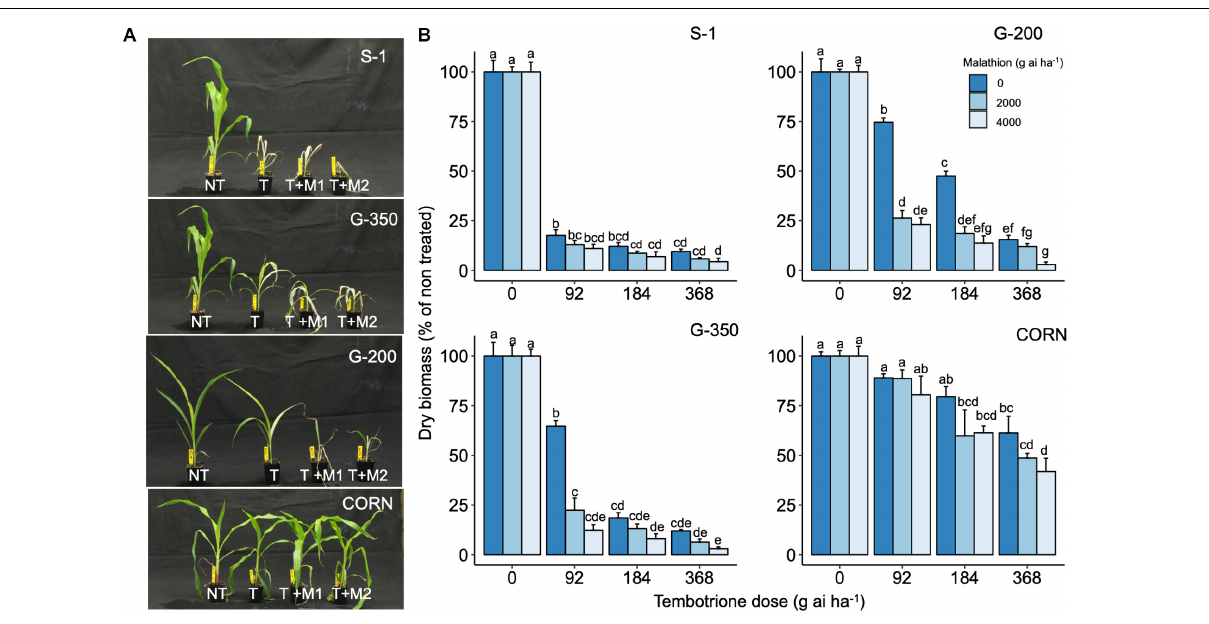
FIGURE 3 | (A) The response of S-1 (susceptible), G-200, G-350 (resistant), and corn to field recommended dose tembotrione (92 g ai ha − 1 ) (T) or malathion treatments (M1: 2,000 g ai ha − 1 ; M2: 4,000 g ai ha − 1 ) followed by field recommended dose tembotrione. NT: non-treated. (B) Above-ground dry biomass of sorghum genotypes when pre-treated with malathion or different doses of tembotrione. The error bars represent the standard error ( n = 8); different alphabets indicate a significant difference between treatments ( p ≤